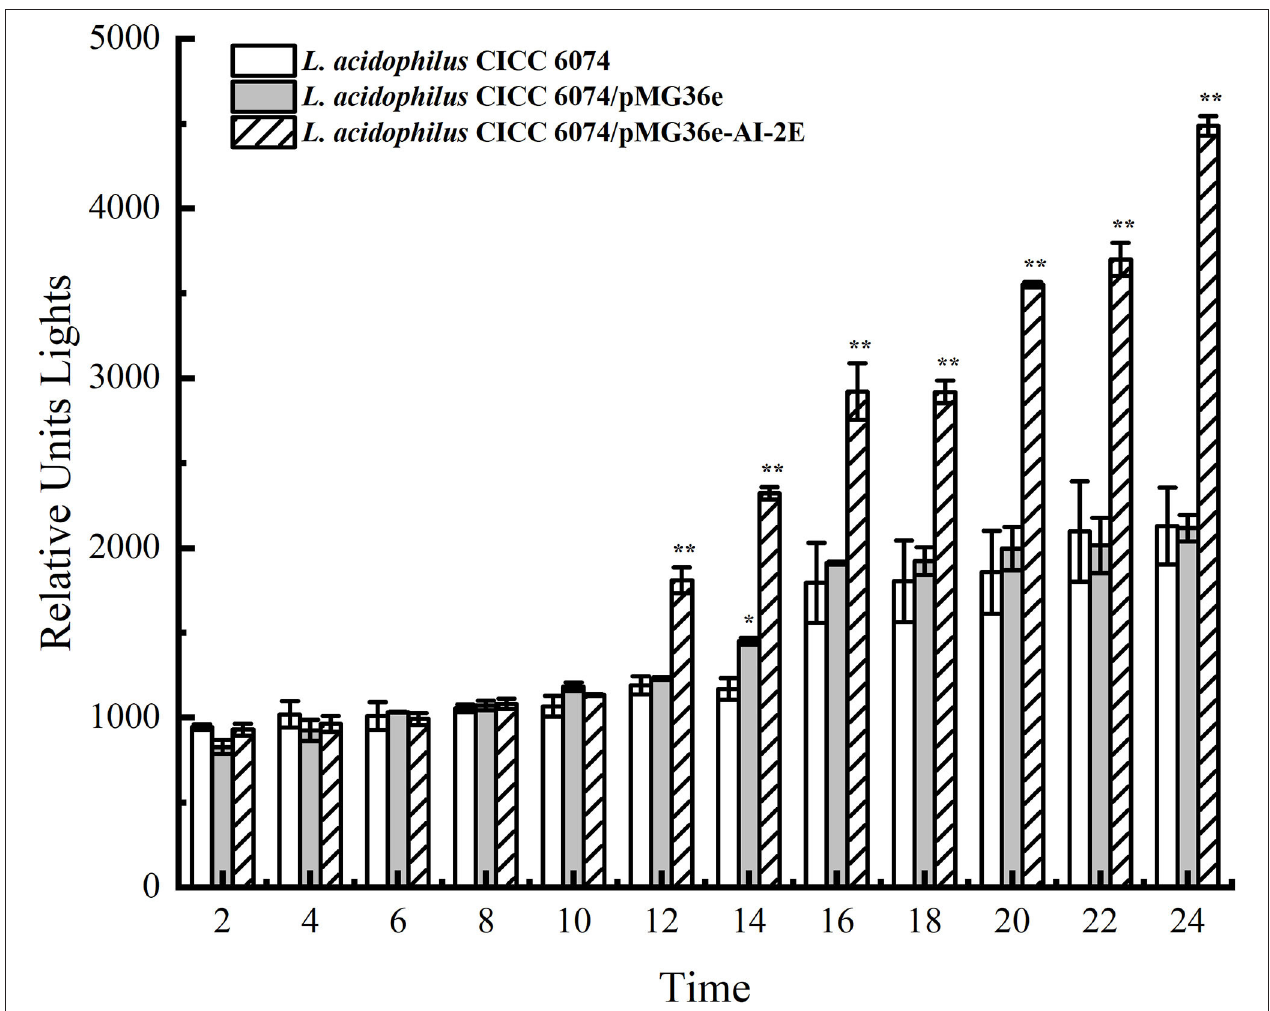
FIGURE 6 | AI-2 activity in culture supernatant with the bacterial cells removed of Lactobacillus acidophilus CICC 6074 wild-type strain, L. acidophilus CICC 6074/pMG36e recombinant strain, and L. acidophilus CICC 6074/pmG36e-AI-2E recombinant strain. Data are presented as mean ± SEM; n ≥ 3; * p < 0.05, ** p < 0.01 compared with the wild-type